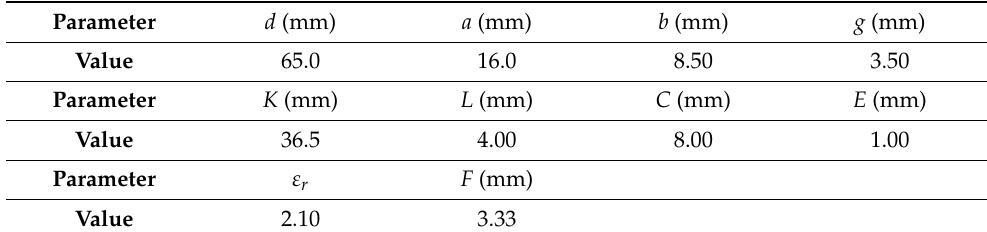
Table 1. Dimensions of the feed and the truncated parabolic reflector.